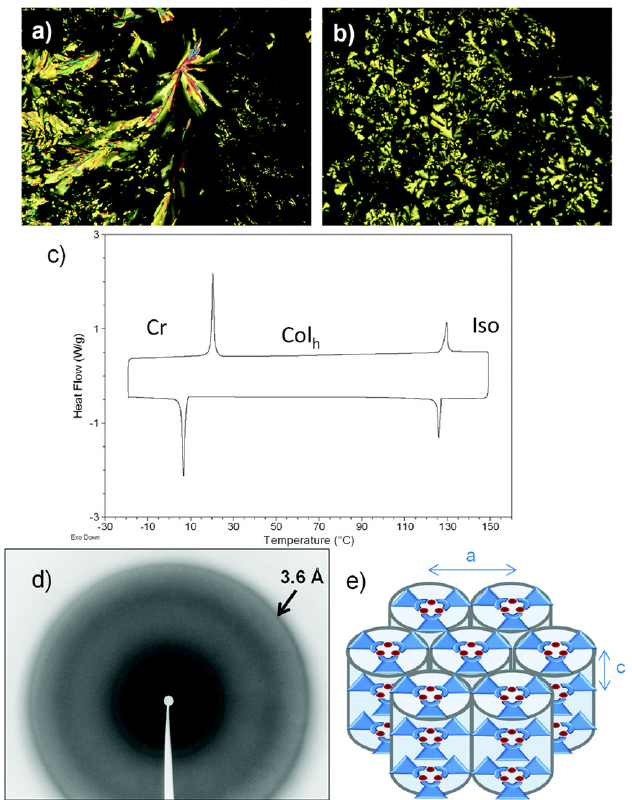
Figure 8. ( a ) Microphotograph of the region between crossed polarizers observed for the texture of the Col h phase of 23a upon cooling of the isotropic liquid at 126 ◦ C. ( b ) Microphotograph of the region between crossed polarizers observed for the texture of the Col h phase of 23b upon cooling of the isotropic liquid at 98 ◦ C. ( c ) DSC thermogram of 23a . ( d ) XRD patterns of the Col h phase of 23a . The arrow indicates the halo corresponding to the stacking distance. ( e ) Self-assembly in the hexagonal columnar mesophase. (Reproduced from ref. [58] with permission from the Royal Society of Chemistry).